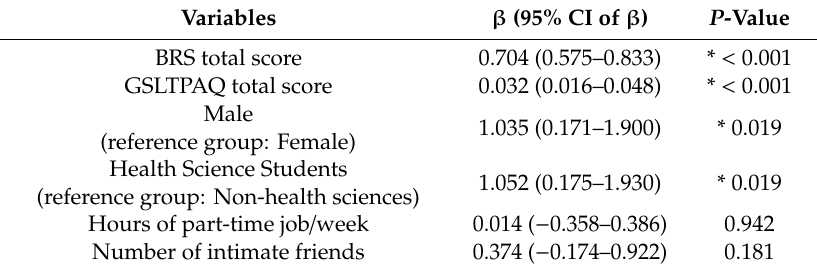
Table 6. Multiple Regression Analysis for predictors of Positive Mental